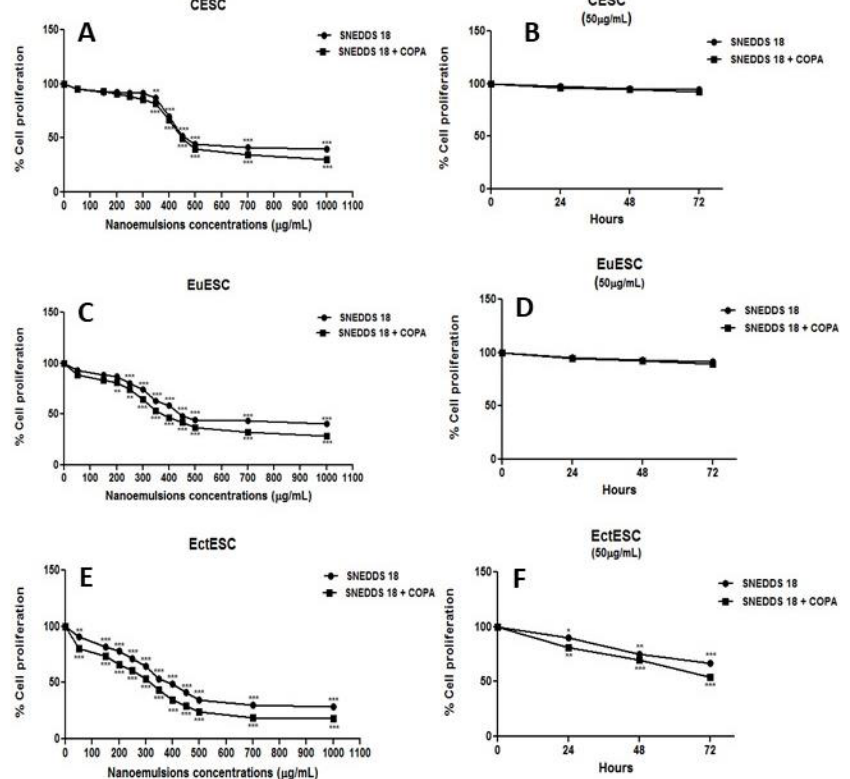
Figure 2. Endometrial stromal cell viability after incubation with nanoemulsions. In ( A ), ( B ), and ( C ), CESC, EuESC, and EctESC were treated with different concentrations of SNEDDS-18 or SNEDDS-18/COPA for 48 h in complete medium. In ( D ), ( E ), and ( F ), CESC, EuESC, and EctESC were treated with 50 µ g/mL of SNEDDS-18 or SNEDDS-18/COPA for 24, 48, or 72 h. Cell proliferation was analyzed by crystal violet method. Data are expressed as mean ± standard deviation of cell viability (in %). * p < 0.05; ** p < 0.01; *** p < 0.001 when comparing nanoformulation-treated groups with nontreated group. CESC: Endometrial stromal cells obtained from topic endometrium of patients without endometriosis; EuESC: Endometrial stromal cells obtained from topic endometrium of endometriosis patients; EctESC: Endometrial stromal cells obtained from ectopic endometrium of endometriosis patients (endometriotic lesions); SNEDDS-18: Nanoemulsion containing Babassu oil; SNEDDS-18/COPA: nanoemulsion containing Babassu oil and Copaiba oil resin.